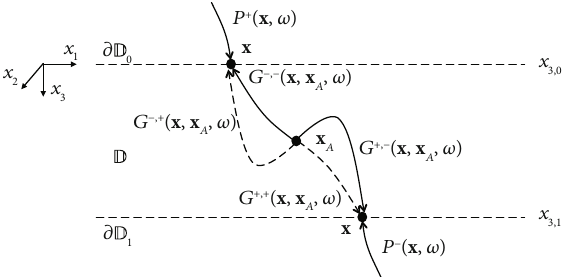
Figure 3: Visualisation of the di ff erent terms in the fi eld-normalised one-way Kirchho ff -Helmholtz integral for forward propagation, formulated by equation (87). The solid Green ’ s functions contribute , ω Þ , the dashed Green ’ s functions to P − ð x to P + ð x A